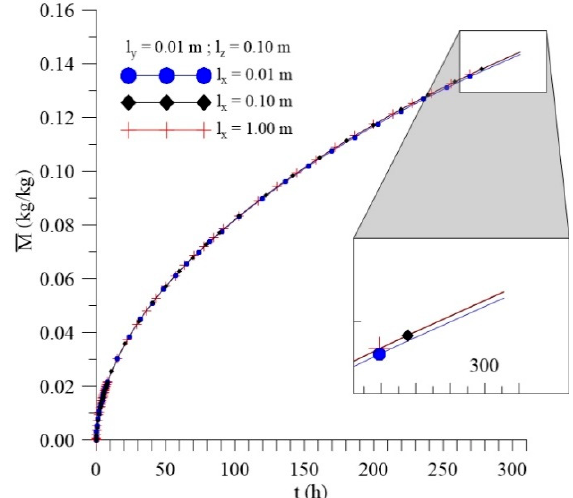
Figure 14. Kinetics of the average moisture content for different distances l x (Cases 8, 9, and 10).